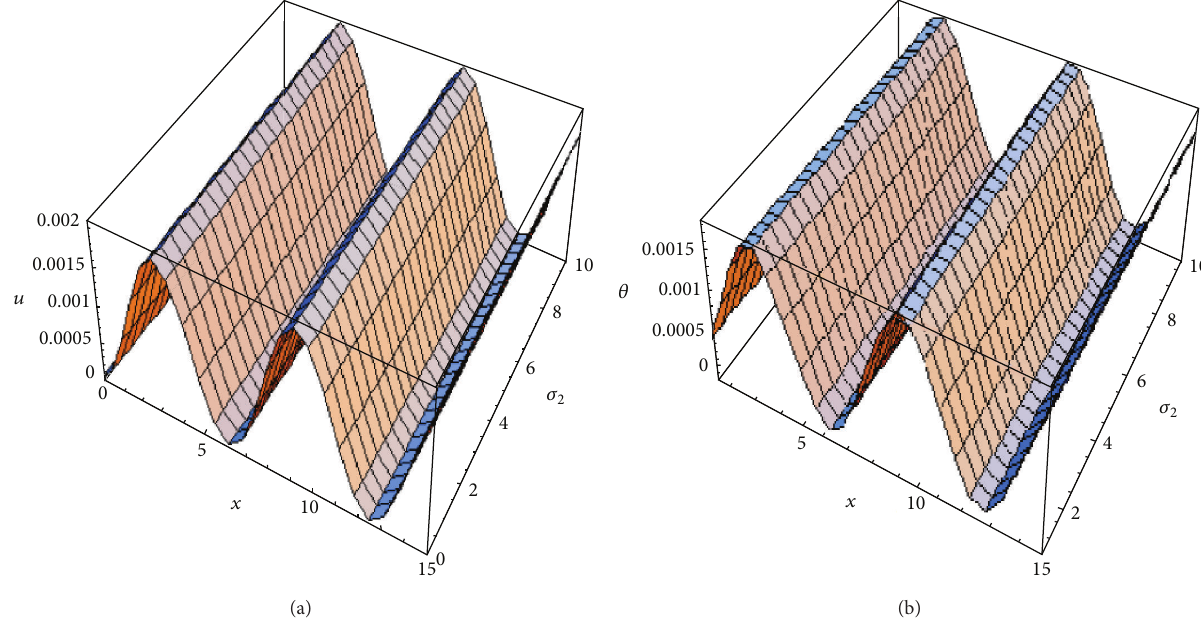
Figure 11: Variations of the displacement 𝑢 and the temperature 𝜃 for various values of the 𝑥 -axis and magnetic field 𝜎 2 when Ω = 𝜎 1 = 0 , = 0.2 , 𝜏 = 0.1 , 𝛿 = 0 , and 𝜔 = 0.02 𝑡 = 0.1 , 𝜏 2 1